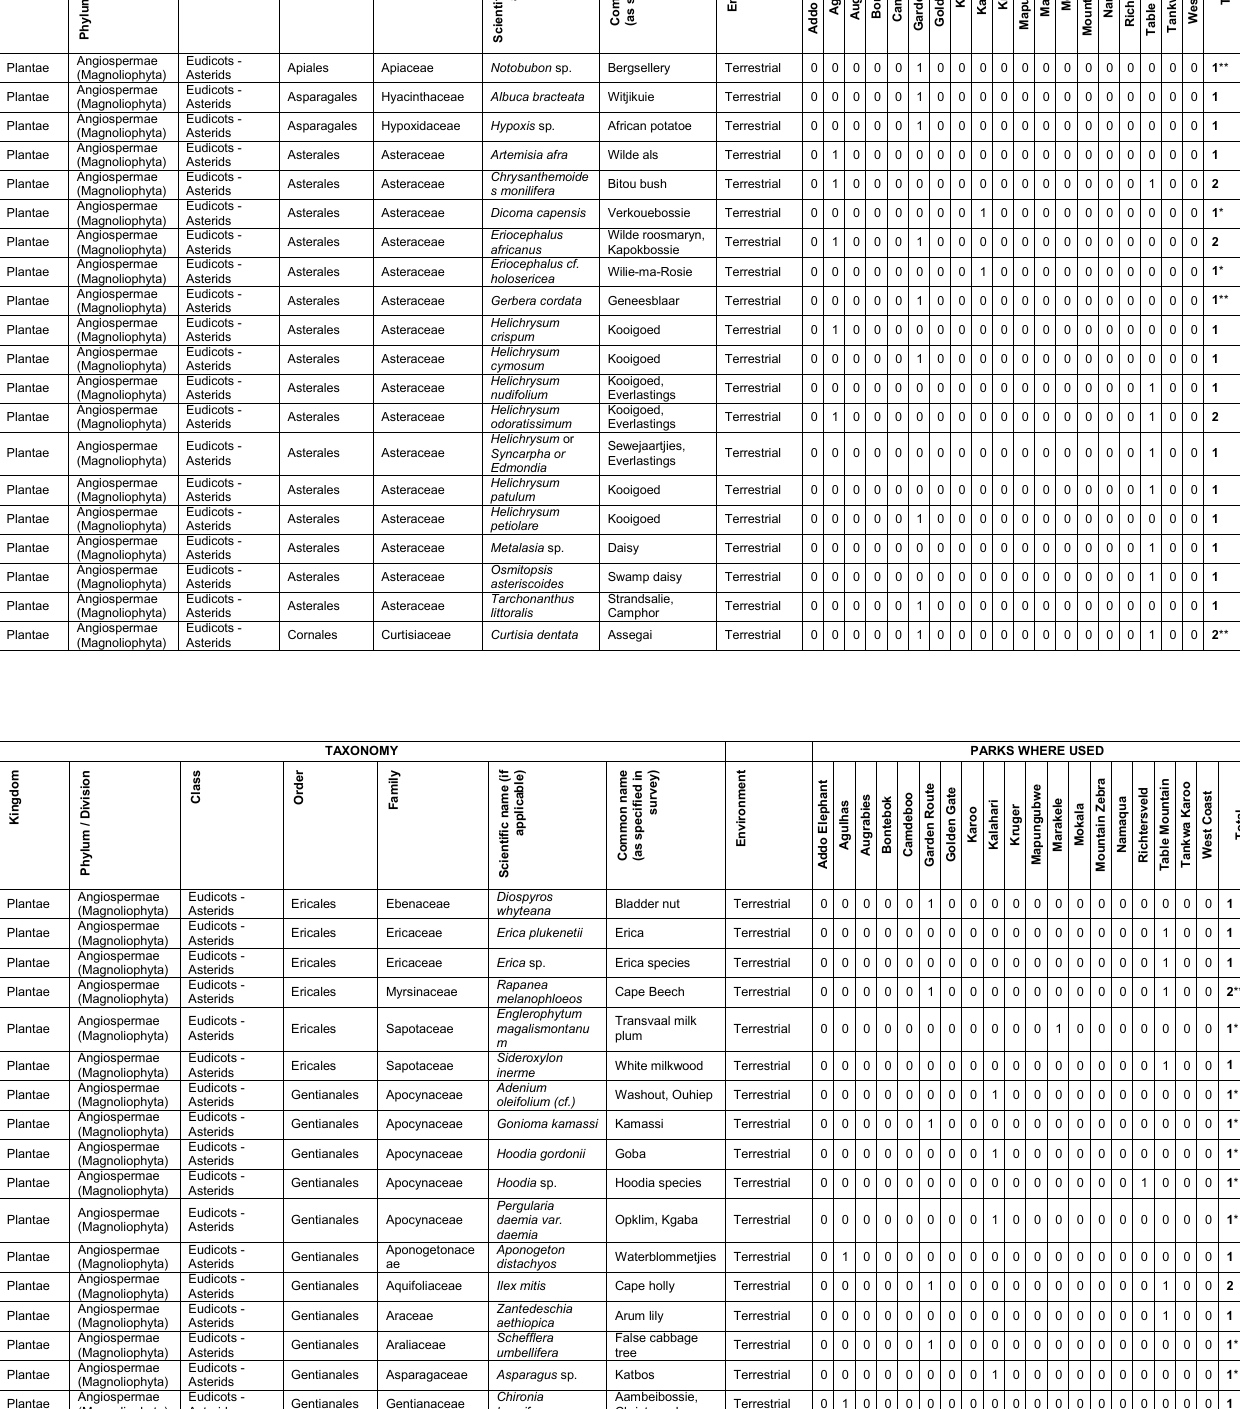
TAXONOMY PARKS WHERE USED on